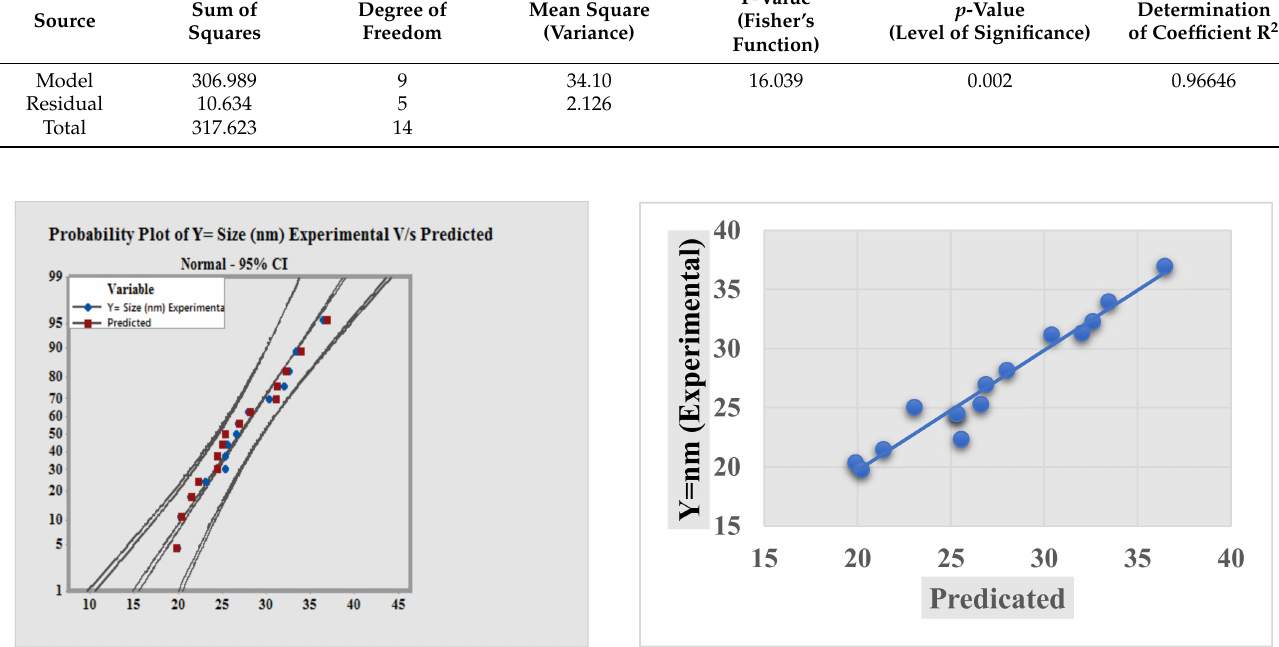
Figure 3. Normal and probability plot for experimental vs. predicted size of